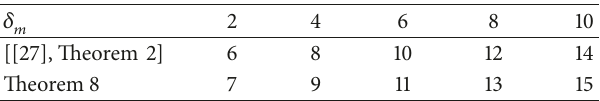
−0.2−0.15−0.1−0.0500.050.10.150.20.250.3 −0.4−0.35−0.3−0.25−0.2−0.15−0.1−0.0500.050.1 Figure 2: Protein concentrations, its estimates, and the estimation error of Example 1. Table 1: Admissible upper bound 𝛿 𝑀 with different 𝛿 𝑚 , when 𝜏 𝑚 = 2 and 𝜏 𝑀 = 5